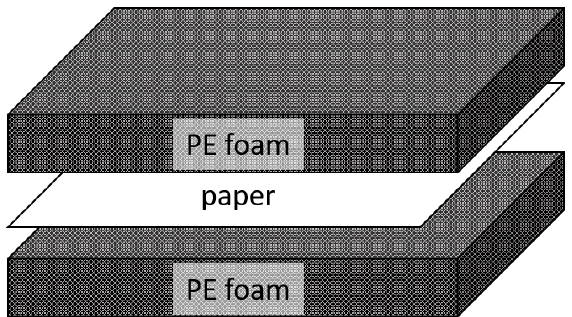
Figure 1. The designation of sandwiches for artificial aging.